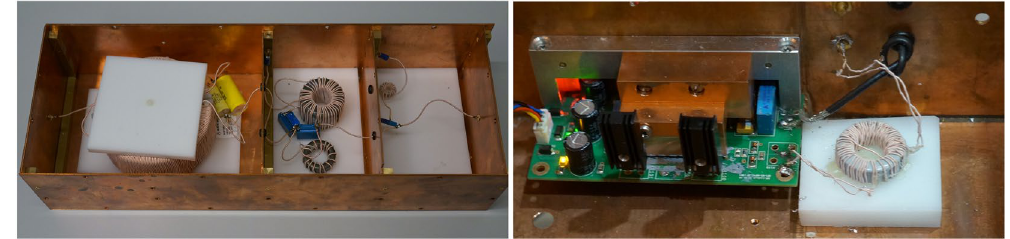
Figure 3. Photographs of the fourth order resonant filter and the LNA connected noise-matching-transformer. The metal structure ontop of the LNA circuit board is used to introduce a cooling through the thermal connection between the integrated circuits and the copper